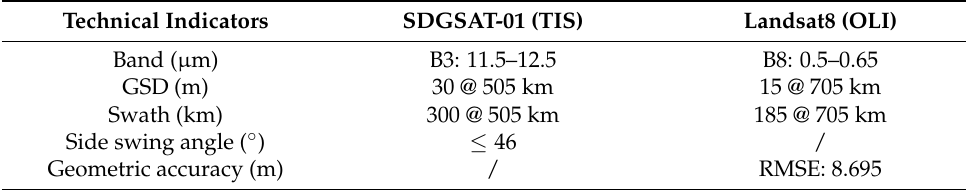
Table 1. The main specifications of SDGSAT-01 TIS and Landsat8